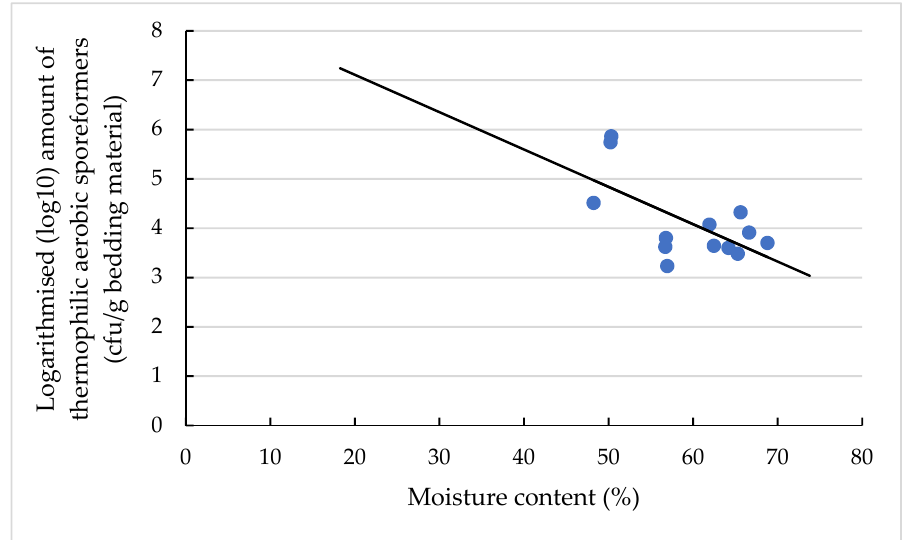
Figure 4. Levels of logarithmised (log10) amount (cfu/g bedding material) of TAS in dependency of moisture content. The individual dots reflect the individual samples, and the black line is the regression line calculated with the equation y = − 0.08x + 8.62 and a coefficient of determination of